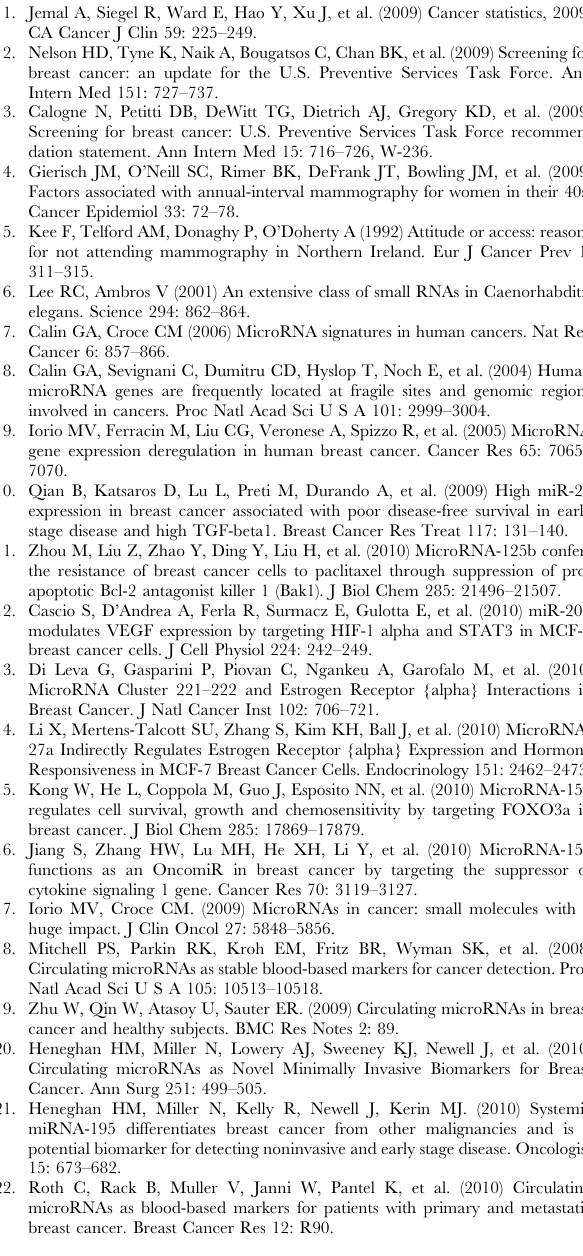
Table S3 Overlap in results of earlier genome-wide studies. miRNAs that were identified in two or more of the five genome-wide studies. Table S4 List of low abundance miRNAs that were statistically significantly associated with breast cancer. List of all miRNAs that were filtered out due to low abundance but, had they not been filtered, would be statistically significantly differentially expressed between pre-resection cases and